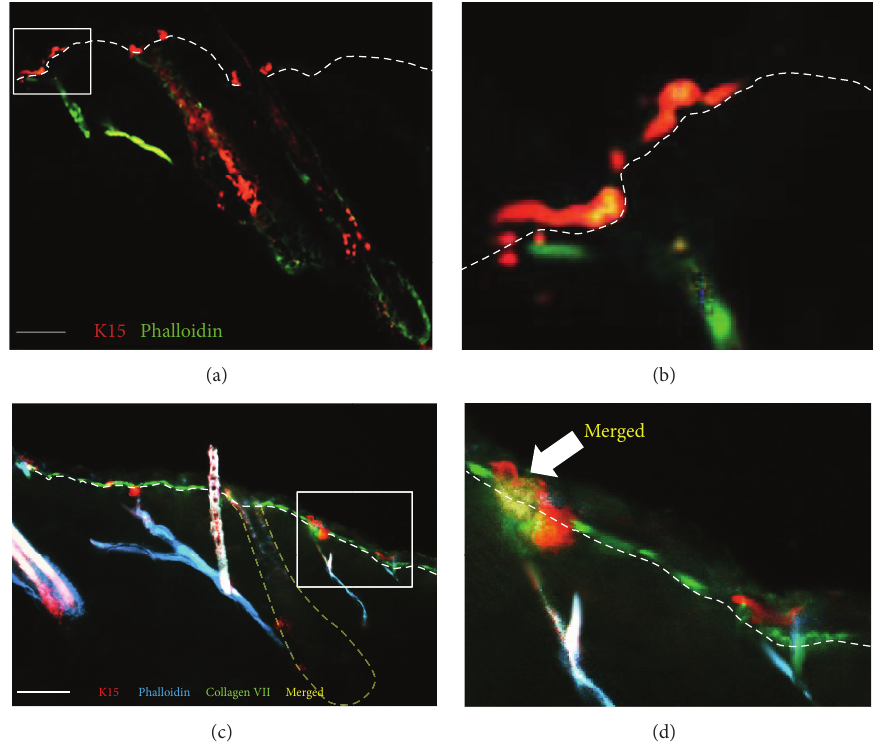
Figure 2: Localization of K15 in the interfollicular epidermis and follicle. Immunofluorescence microscopy showing patterns of phalloidin, expression of 𝛼 5 integrin, K15, and collagen VII. (a) K15 (red) demonstrates a heterogeneous expression in the basal epidermis and follicular bulge. K15 expression is evident at the distal attachment of the APM (green) in the epidermis. (b) Magnified view of the distal attachment of the APM. K15 (red) expression at the distal APM (green) attachment. (c) Triple immunofluorescence staining for K15 (red), collagen VII (green), and phalloidin (blue) showing K15 expressing cells and cells stained with phalloidin in the basal epidermis at the distal tip of the arrector pili muscle (blue) 100 𝜇